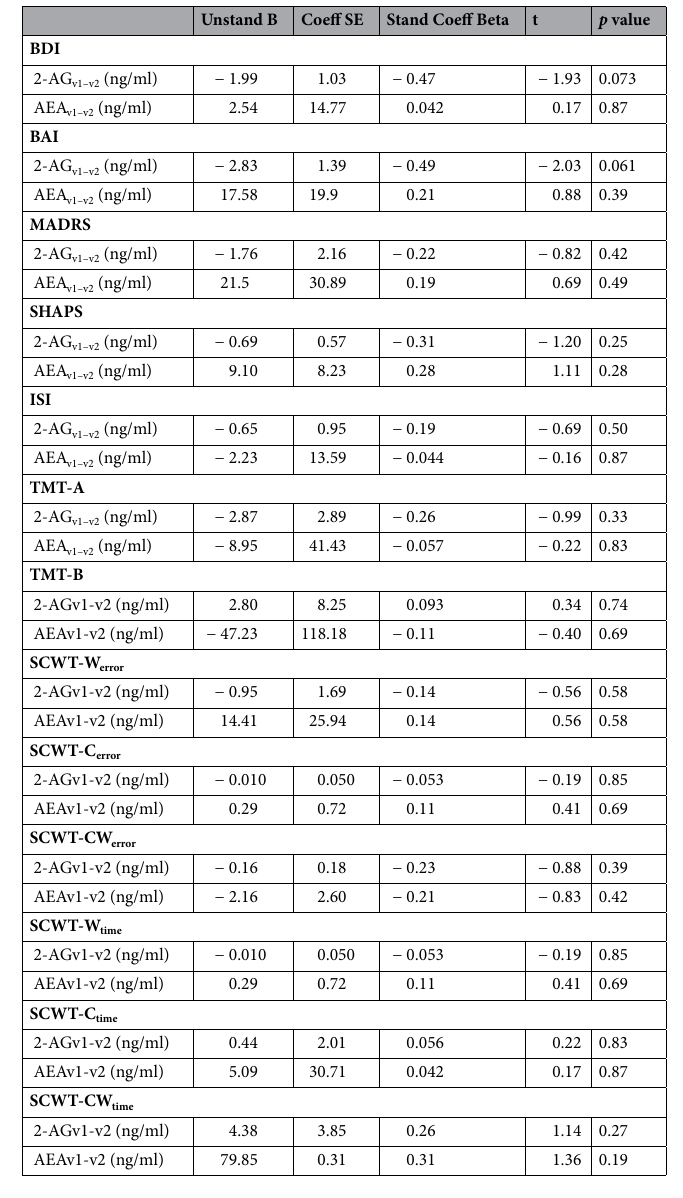
Table 2. Linear regression tests of serum 2-AG and AEA changes and alteration of symptoms between visit 1 and visit 2 . BDI Beck Depression Inventory, MADRS Montgomery-Asberg Depression Scale, BAI Beck Anxiety Inventory, SHAPS Snaith–Hamilton Pleasure Scale, ISI Insomnia Severity Index, TMT Trail Making Test, SCWT Stroop Colour-Word Test, 2-AG 2-arachidonoylglycerol, AEA